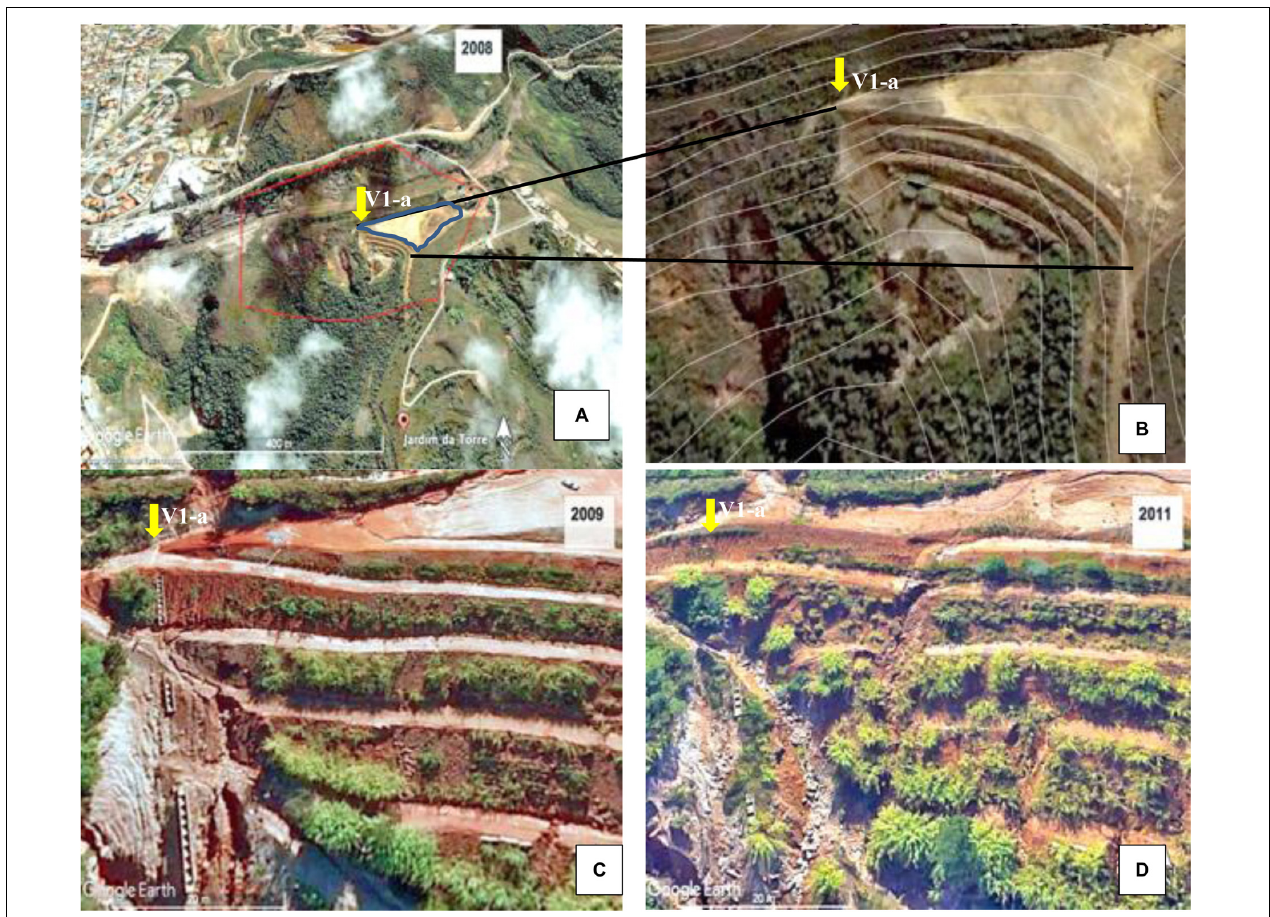
FIGURE 9 | Detail of the embankment built for the waste landfill showing the beginning of the gully V1. (A) Satellite image of waste landfill location in the area – delimited in red and waste landfill plateau delimited in blue (2008). (B) Satellite image of the waste landfill magnified, overlapping level curves (2008); (C) Detail of the beginning of erosion on the right side of the built waste landfill and the hydraulic ladder (2009); (D) Collapsed hydraulic ladder and new erosion points at the top of the slope (2011); yellow arrows indicate the same location in V1-a. Source: Adapted from Google Earth,